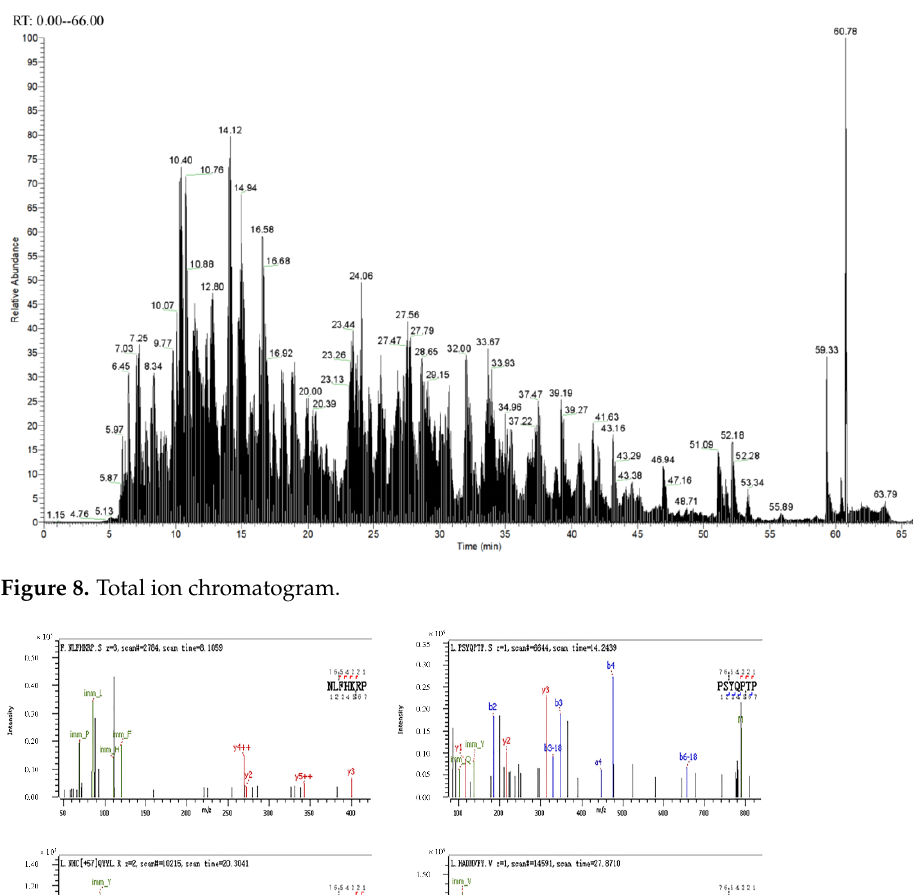
Figure 9. Secondary mass spectra of HADMVFY, NHCQYYL, NLFHKRP and PSYQPTP. The series of b and y ions are fragment ions produced when the peptide breaks at the peptide bond. Table 5. LC-MS/MS identification of the antioxidant